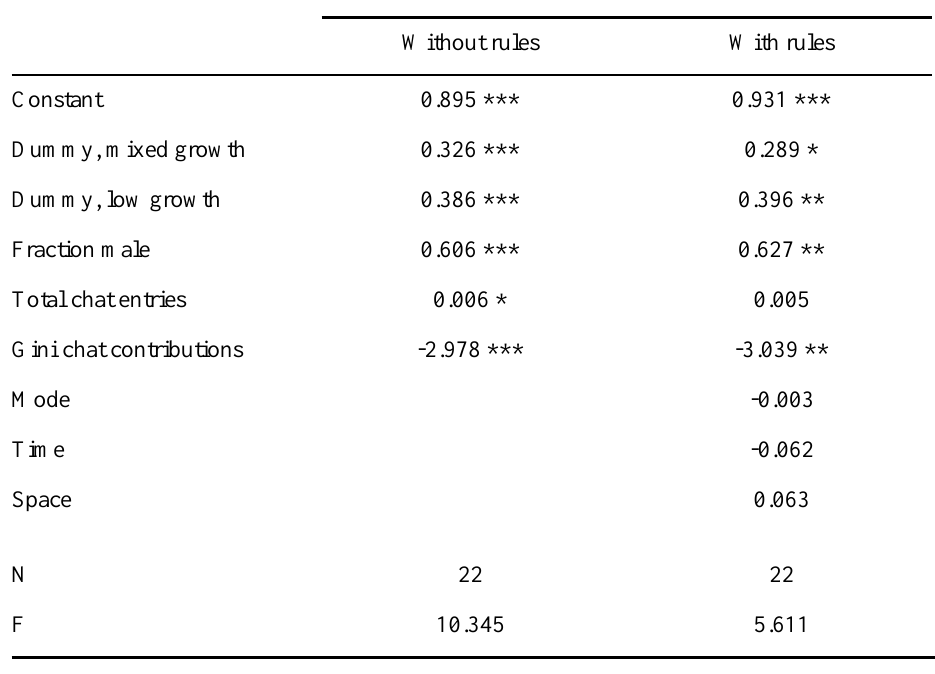
Table 8. The statistical estimation of the relationship between relative increase in tokens collected in round 3 vs. round 2 and the occurrence of explicit discussions on how, when, and where to collect tokens.